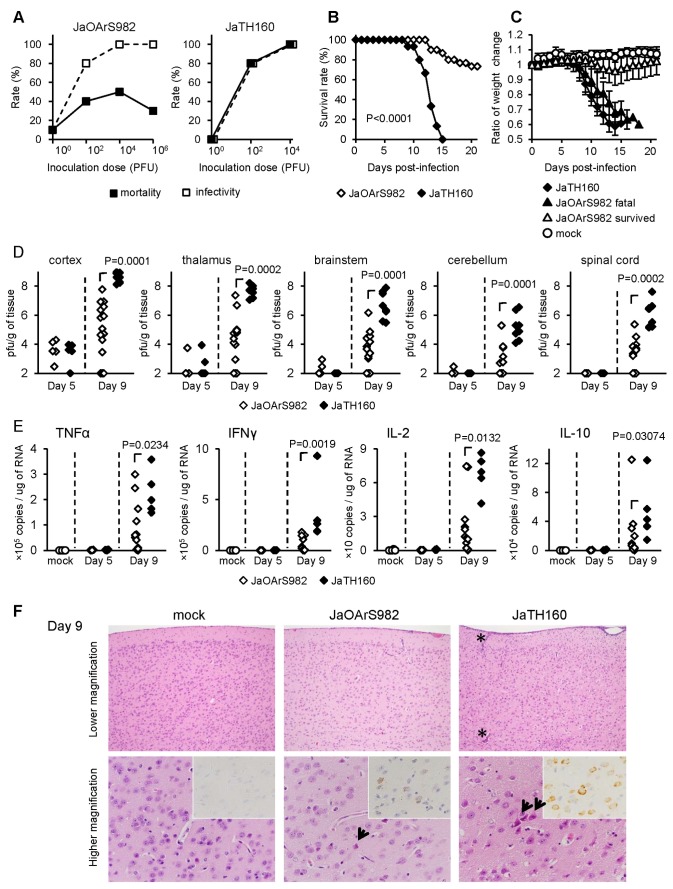
Mortality and pathogenicity of B6 mice subcutaneously infected with JaOArS982 and JaTH160.(A) Mortality and infectivity rates of B6 mice (n=10) following subcutaneous infections with 100, 102, 104 and 106 pfu of JaOArS982 and JaTH160. Mice were recorded for 21 days and no mice died after 21 days. Infectivity was determined by anti-JEV IgG antibody seroconversion for more than 1:1000 of IgG ELISA titer. (B and C) B6 mice were subcutaneously infected with 104 pfu of JaOArS982 (n=30) and JaTH160 (n=15).Survival curves P: Gehan-Breslow-Wilcoxon Test. (C) The averages ratio of weight change of living mice at the time points compared with those of day 0 following subcutaneous infections with 104 pfu of JaOArS982 (n=30) and JaTH160 (n=15). Error bars represent the standard deviations. (D) Viral loads in distinct regions of the CNS following subcutaneous infections with 104 pfu of JaOArS982 (Day 5: n=5, Day 9: n=15) and JaTH160 (Day 5: n=5, Day 9: n=8). P: Mann Whitney test. (E) mRNA levels of TNF-α, IFNγ, IL-2 and IL-10 quantified by real-time PCR in the brain cortex of B6 mice infected with 104 pfu of JaOArS982 (Day 5: n=5, Day 9: n=12), JaTH160 (Day 5: n=5, Day 9: n=5) and mock (n=8). P: Mann Whitney test. (F) Histopathological features of brain cortex in B6 mice infected with 104 pfu of JaOArS982 and JaTH160 at 9 days pi. JEV antigens were detected using E-protein specific JEV antibody (insets). Each experiment represents six and four mice infected with JaOArS982 and JaTH160, respectively. JaOArS982-infected mice showed slight inflammatory infiltration in meninges. In brain cortex, a few degenerated cells were presented (arrow) and were virus antigen-positive cells. In JaTH160-infected mice, severe inflammatory reactions were seen in meninges and perivascular area (asterisks). Many virus antigen-positive cells were detected in degenerated neuronal cells of the cortex (arrows).